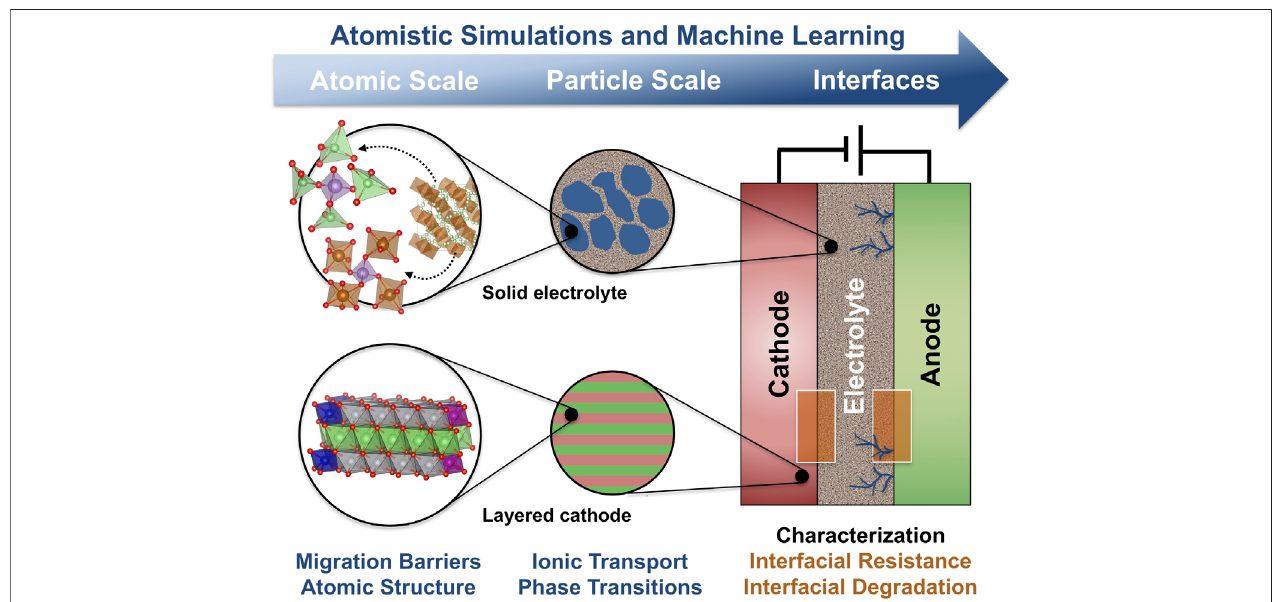
FIGURE 1 | The properties of solid-state batteries, such as stability and rate capability, are often dependent on atomic-scale phenomena, such as phase changes or structural motifs at interfaces and grain boundaries. Machine learning techniques can increase the length and time scale that atomistic simulations can access.